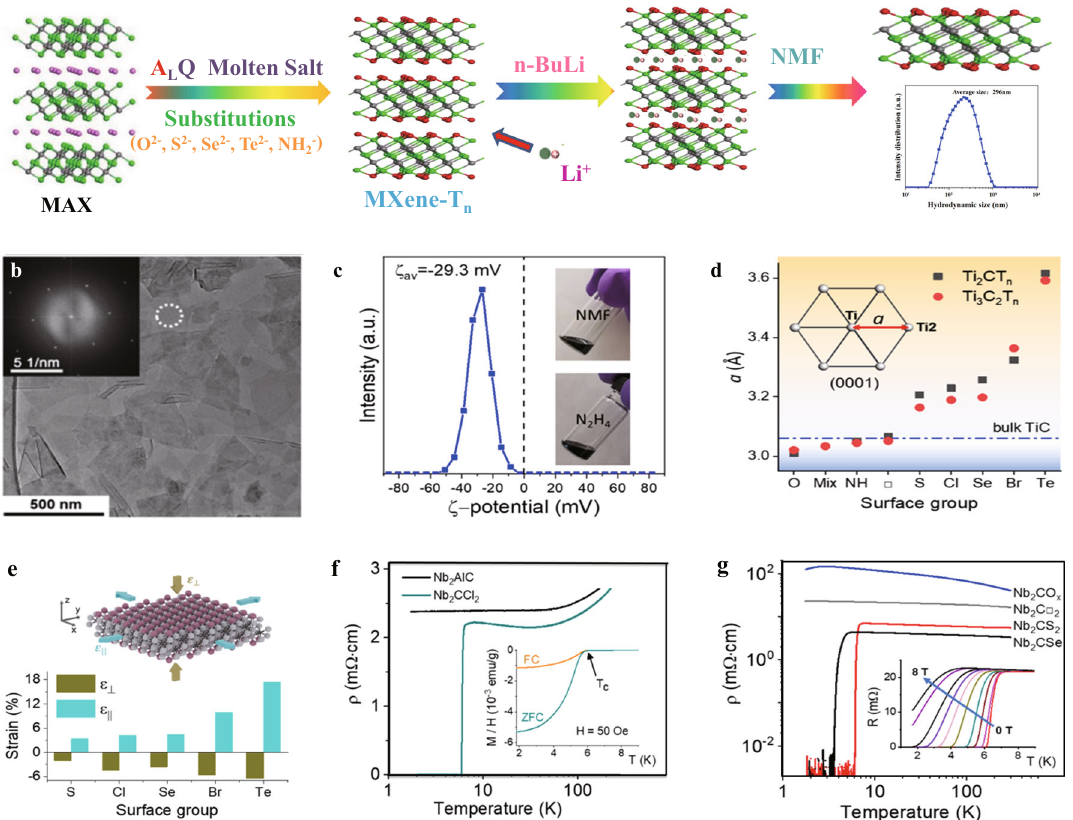
Fig. 5 The synthesis of MXenes from MAX phase by Lewis acid etching. a Surface etching and delamination of MXenes in molten salts. b TEM image of Ti 3 C 2 Cl 2 MXenes fl akes. c Negative zeta potential of the delaminated MXenes in N-methylformamide (NMF). d The correlation of the in-plane lattice constant ( a ) and surface group (T n ) for Ti 2 CT n and Ti 3 C 2 T n MXenes. e Surface groups and the corresponding biaxial straining of Ti 3 C 2 T n MXenes lattice. f , g Electronic transport and superconductivity in Nb 2 CT n MXenes 60 . Copyright 2020, American Association for the Advancement of